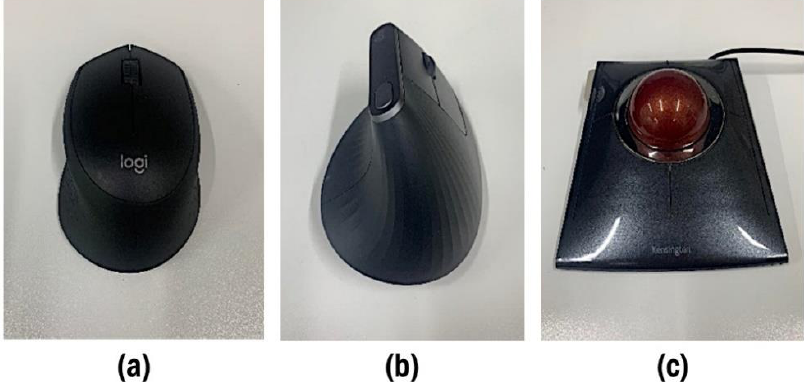
Figure 2. Pointing devices used in this study; ( a ) conventional mouse, ( b ) vertical mouse, and ( c ) trackball.